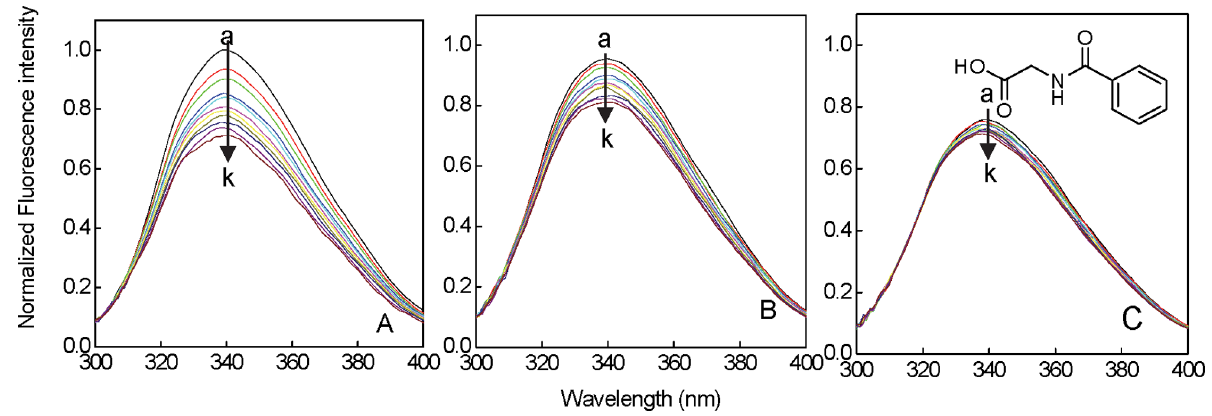
Figure 1. Normalized fluorescence emission spectra of HSA in the presence of different concentrations of HA at (A) 25 6 C, (B) 30 6 C, and (C) 37 6 C. a-k: 0—10 m M of HA at increments of 1 m M. The inset corresponds to the molecular structure of HA.